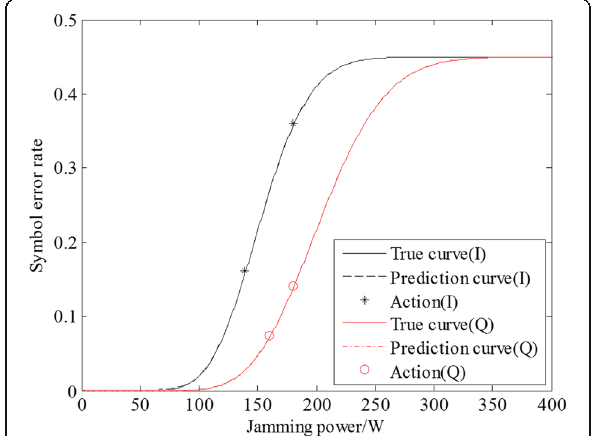
Fig. 4 Environmental noise belongs to the AWGN distribution. The predicted results in the in-phase and quadrature phase almost overlapped with the real SER curve, where the noise belongs to the AWGN distribution, and the dictionary was constructed with the AWGN assumption